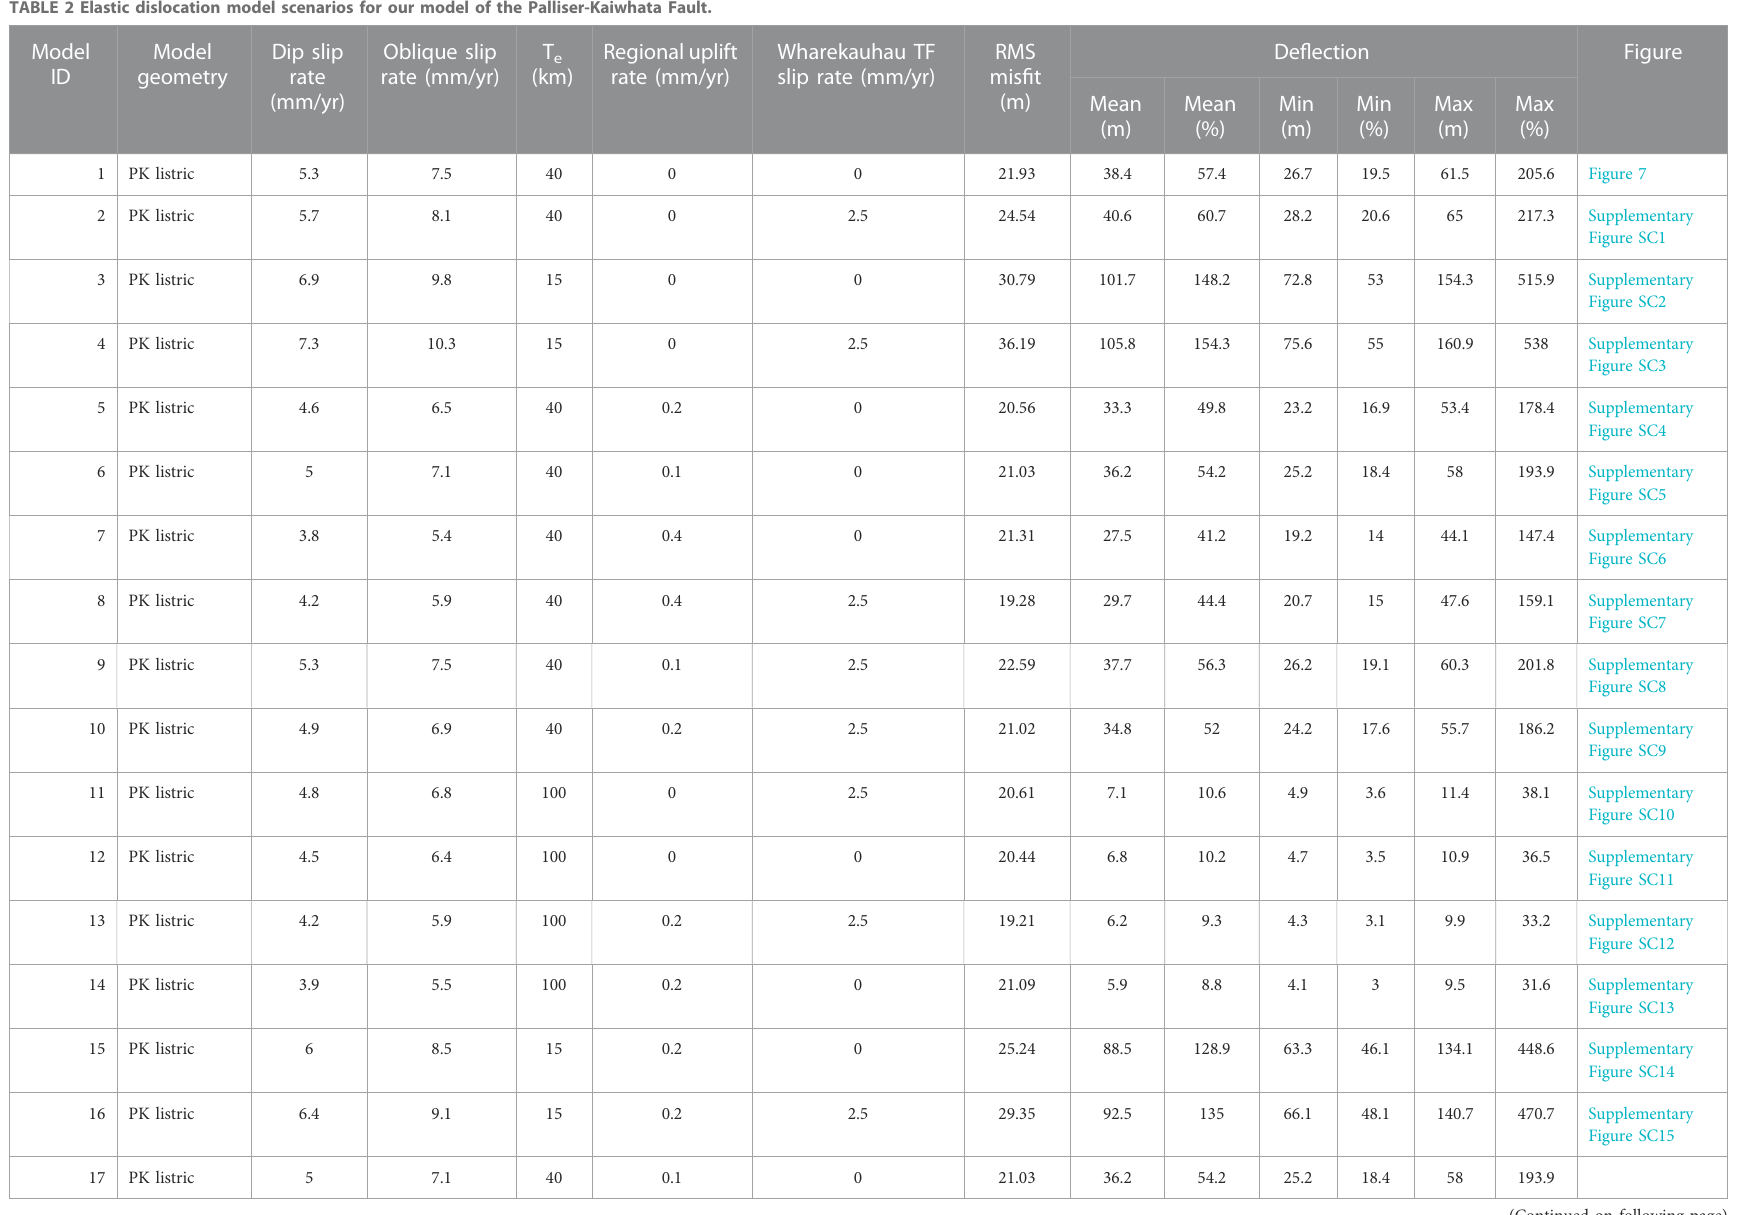
TABLE 2 Elastic dislocation model scenarios for our model of the Palliser-Kaiwhata Fault. Model